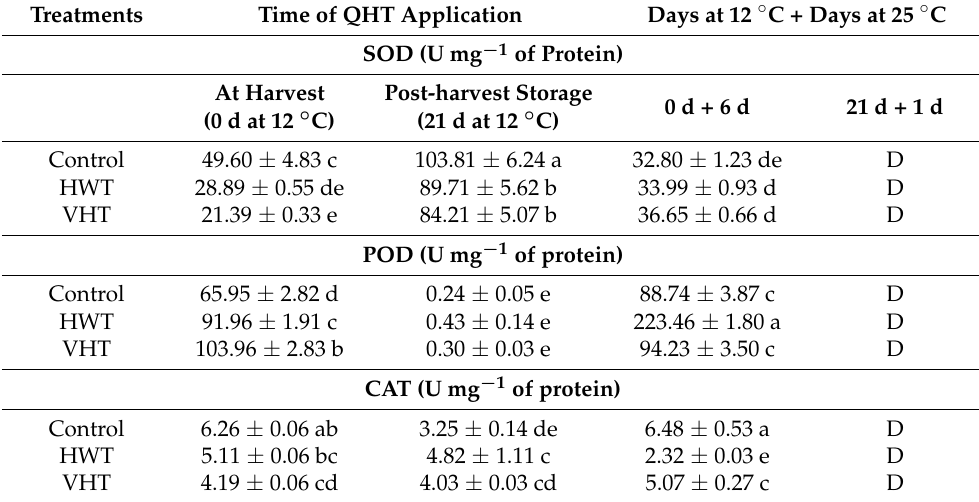
Table 3. Effect of the heat treatments applied at harvest and post-harvest storage on the superoxide dismutase (SOD), peroxidase (POD), and catalase (CAT) enzyme activities of mango fruits. Data are presented as mean ± SE ( n = 3). Different letters indicate significant differences according to LSD at p ≤